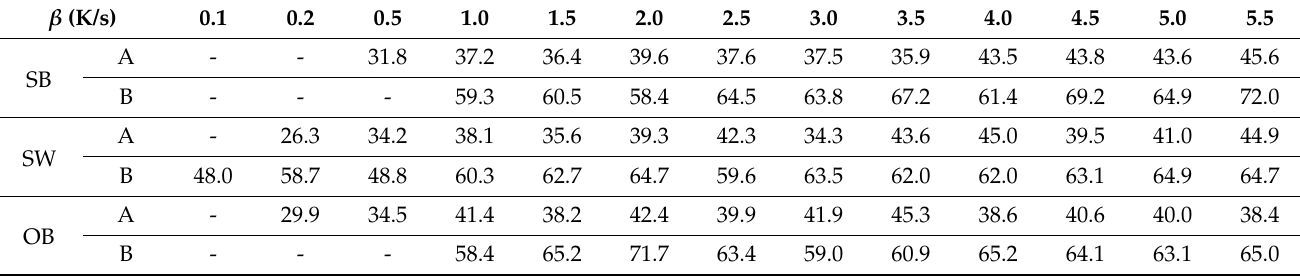
Figure 7. Ignition capacity defined by 20 W/g and 5% total heat release for results by Method A and B. Table 4. Ignition capacity calculation for ten wood samples with Method A and Method B by 20 W/g definition.